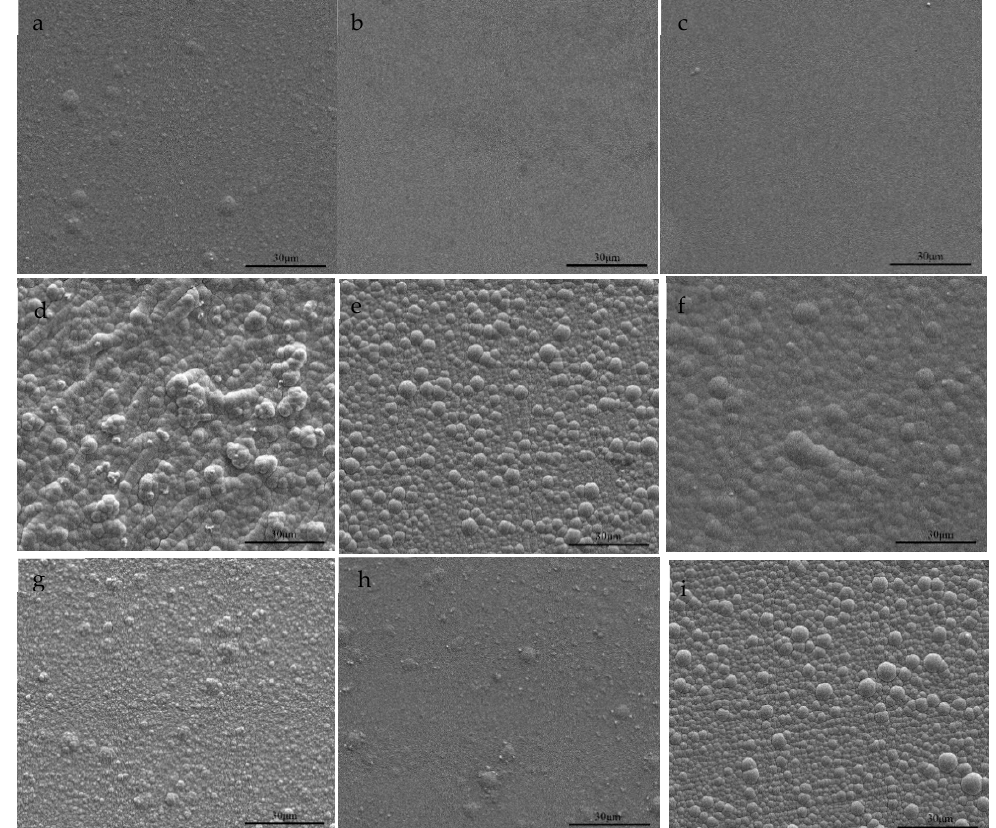
Figure 7. SEM images of FeNi electrodeposited films: ( a – c ) 0.015 M FeSO 4 , ( d – f ) 0.03 M FeSO 4 , ( g – i ) 0.05 M FeSO 4 . At each FeSO 4 concentration, the deposition current densities are 15 mA·cm − 2 , 25 mA·cm − 2 and 50 mA·cm − 2 , respectively.